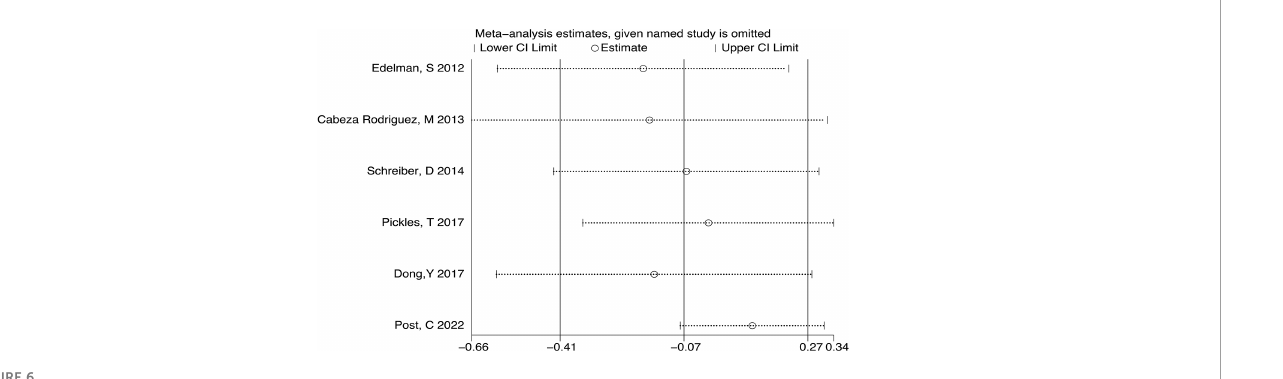
FIGURE 6 Sensitivity analysis for OS of 6 retrospective studies.